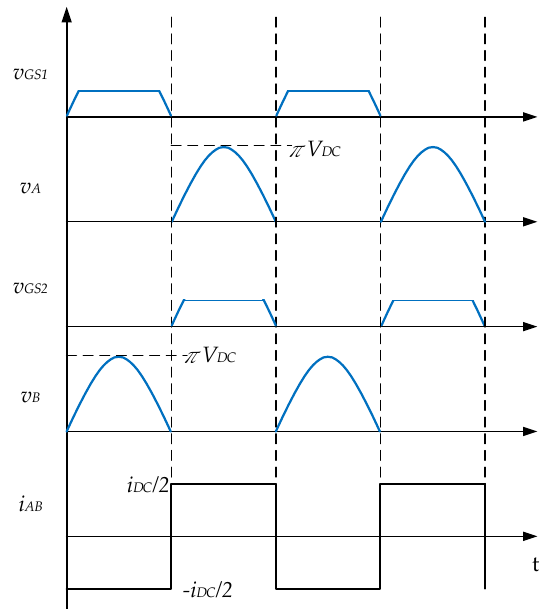
Figure 3. Operation principle of an ideal autonomous inverter at steady state.